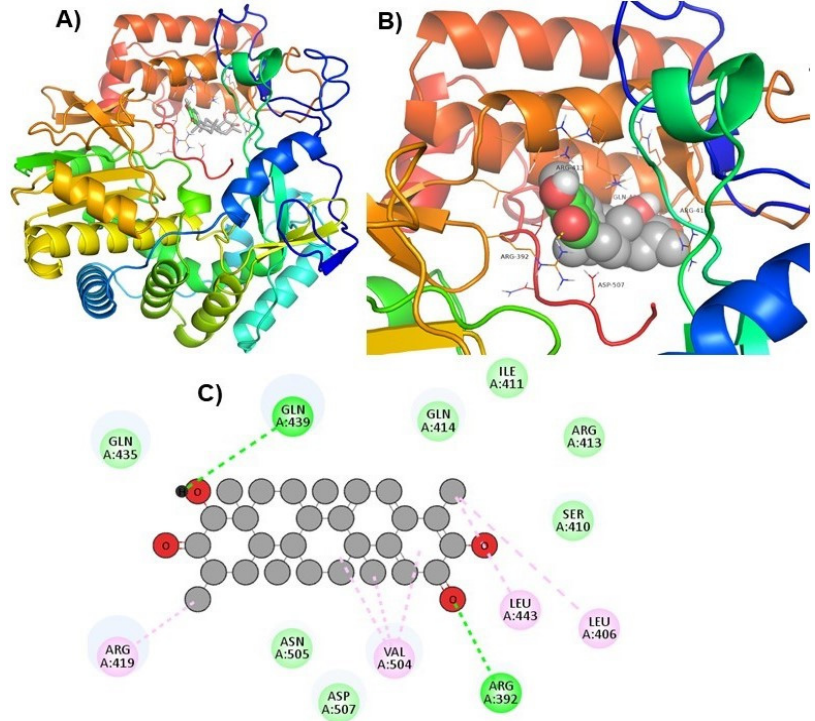
Figure 2. Visualization of ZINC66112069 in RdRp's active site. 3D views of whole protein and ligand interactions ( A ), 3D views of interacting residues of the RdRp active site with ZINC66112069 ( B ), and 2D views of the RdRp residue interacting with ZINC66112069 ( C ).